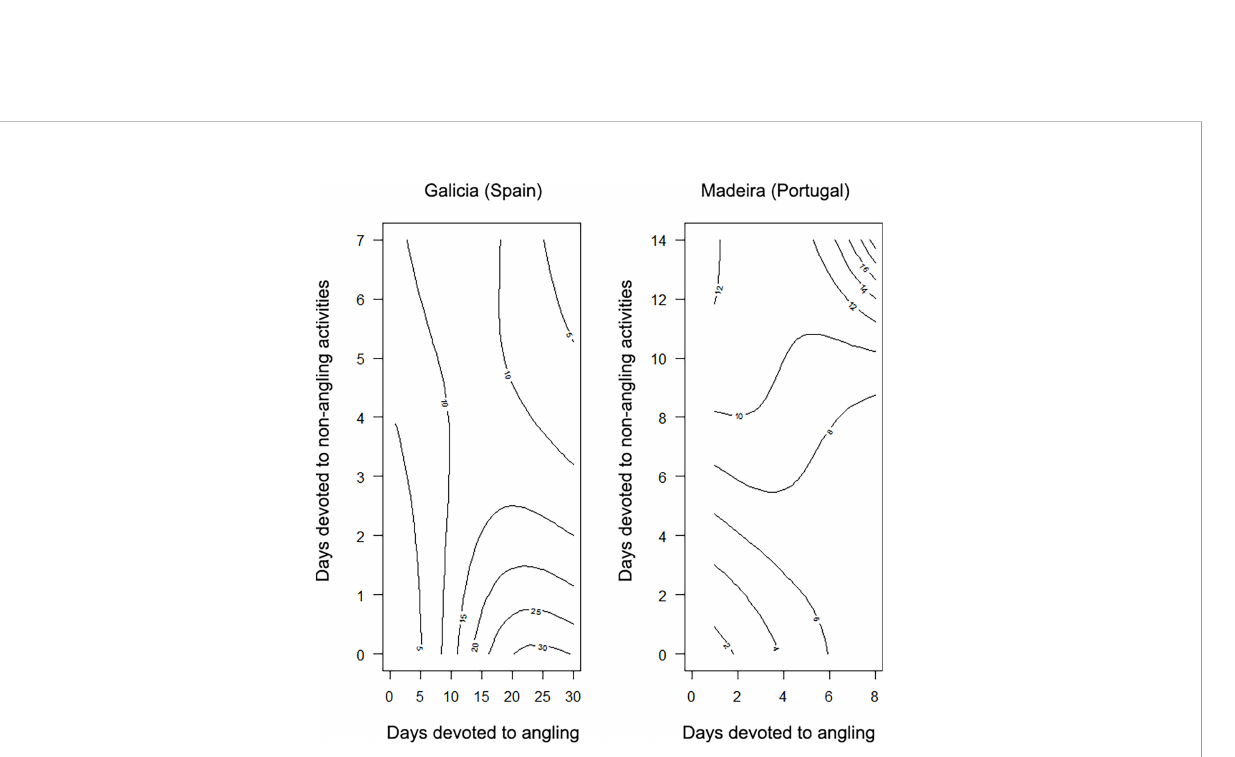
FIGURE 5 Partial effect of the interaction between the days devoted to angling and the days devoted to other recreational activities on the total days of the vacation in Spain (Galicia) and Portugal (Madeira). It shows the predictions of the total vacation duration estimated by a